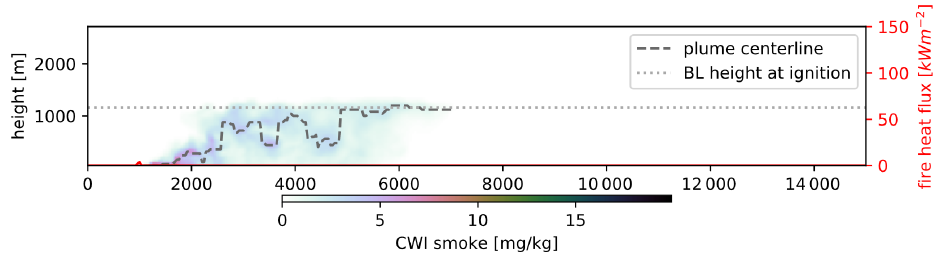
Figure B1. Fixed aspect ratio plot of CWI smoke from a sample non-penetrative plume (W5F8R3). Plume centerline and z i shown in dashed and dotted grey,